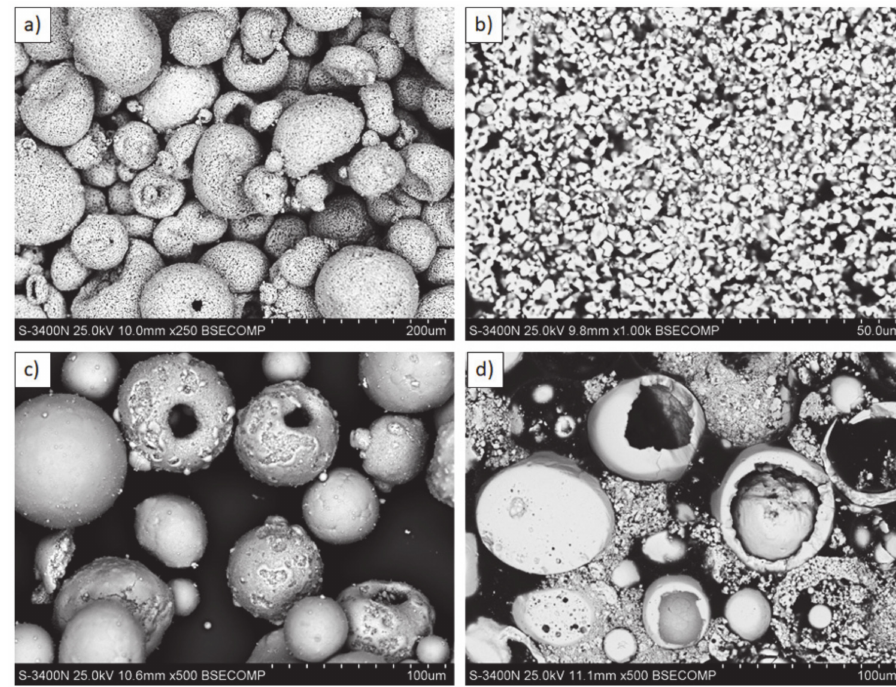
Figure 1. Feedstock powders: ( a , b ) La 2 Zr 2 O 7 : morphology and cross section; ( c , d ) 8YSZ: morphology and cross section.